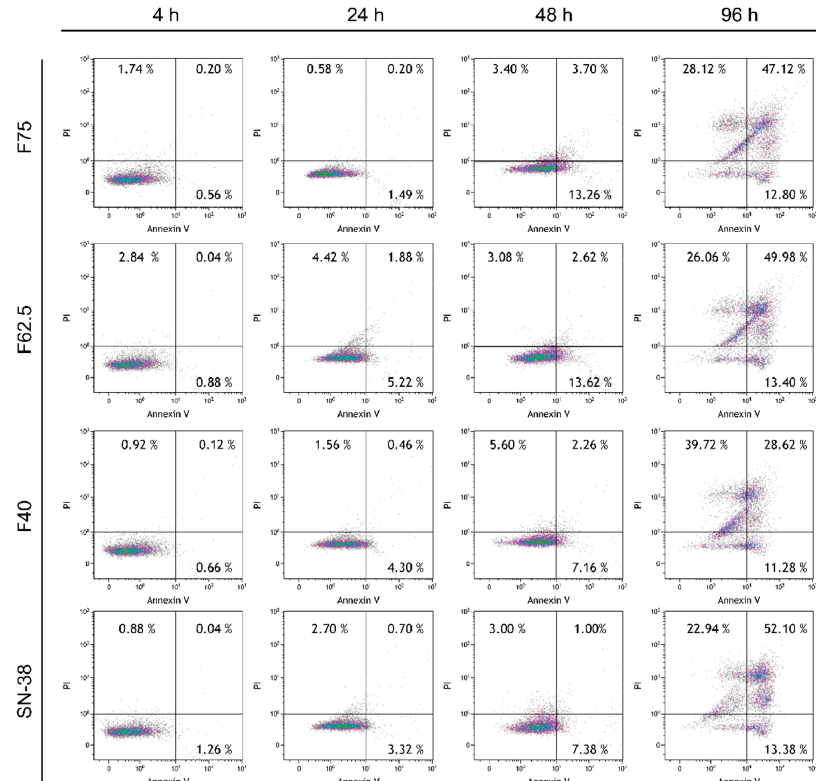
Figure 9. The annexin V–PI apoptosis results after treatment with the SN-38 control and sBSANPs at BSA 40, 62.5, and 75 mg/mL concentrations from 4 to 96 h. Note: The lower left quadrant shows viable cells, the lower right shows early apoptotic cells, the upper right shows late apoptotic cells, and the upper left shows necrosis cells. From 4 to 48 h, the cells moved from the lower left to the lower right quadrant, showing that apoptosis was in progress. At 96 h, cells were observed in the upper right and upper left, indicating that the cells were in late apoptosis or necrosis. The results implied that the SN-38 and sBSANP formulations triggered apoptosis, a desired form of cell death.